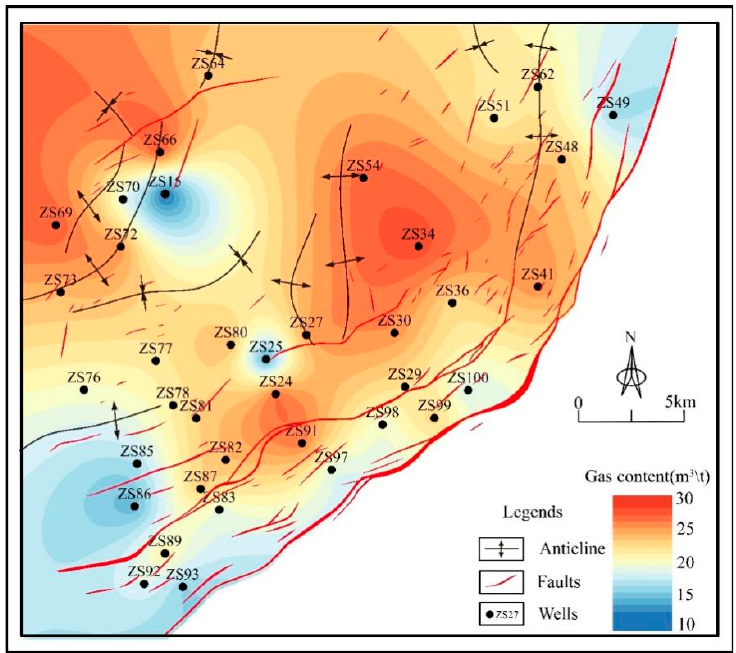
Figure 12. Gas content distribution of the No.3 coal seam in Zhengzhuang block.